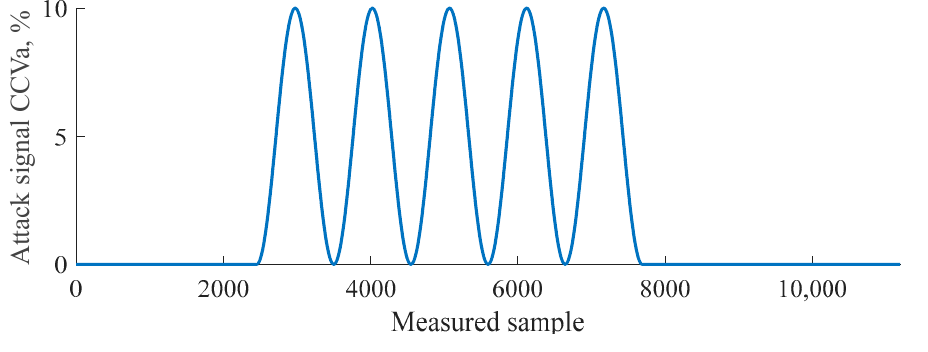
Figure 5. Sinusoidal attack signal.